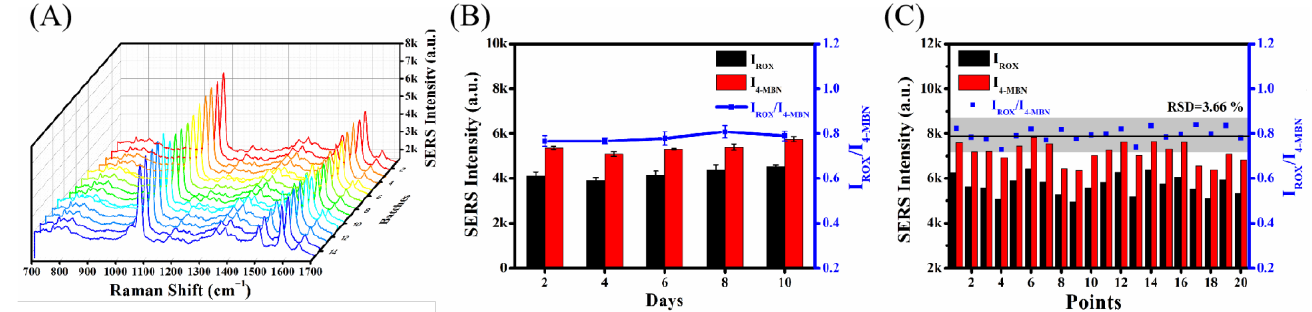
Figure 9. Evaluation of the established ratiometric SERS aptasensor. ( A ) Reproducibility. ( B ) Stability. ( C ) Uniformity.